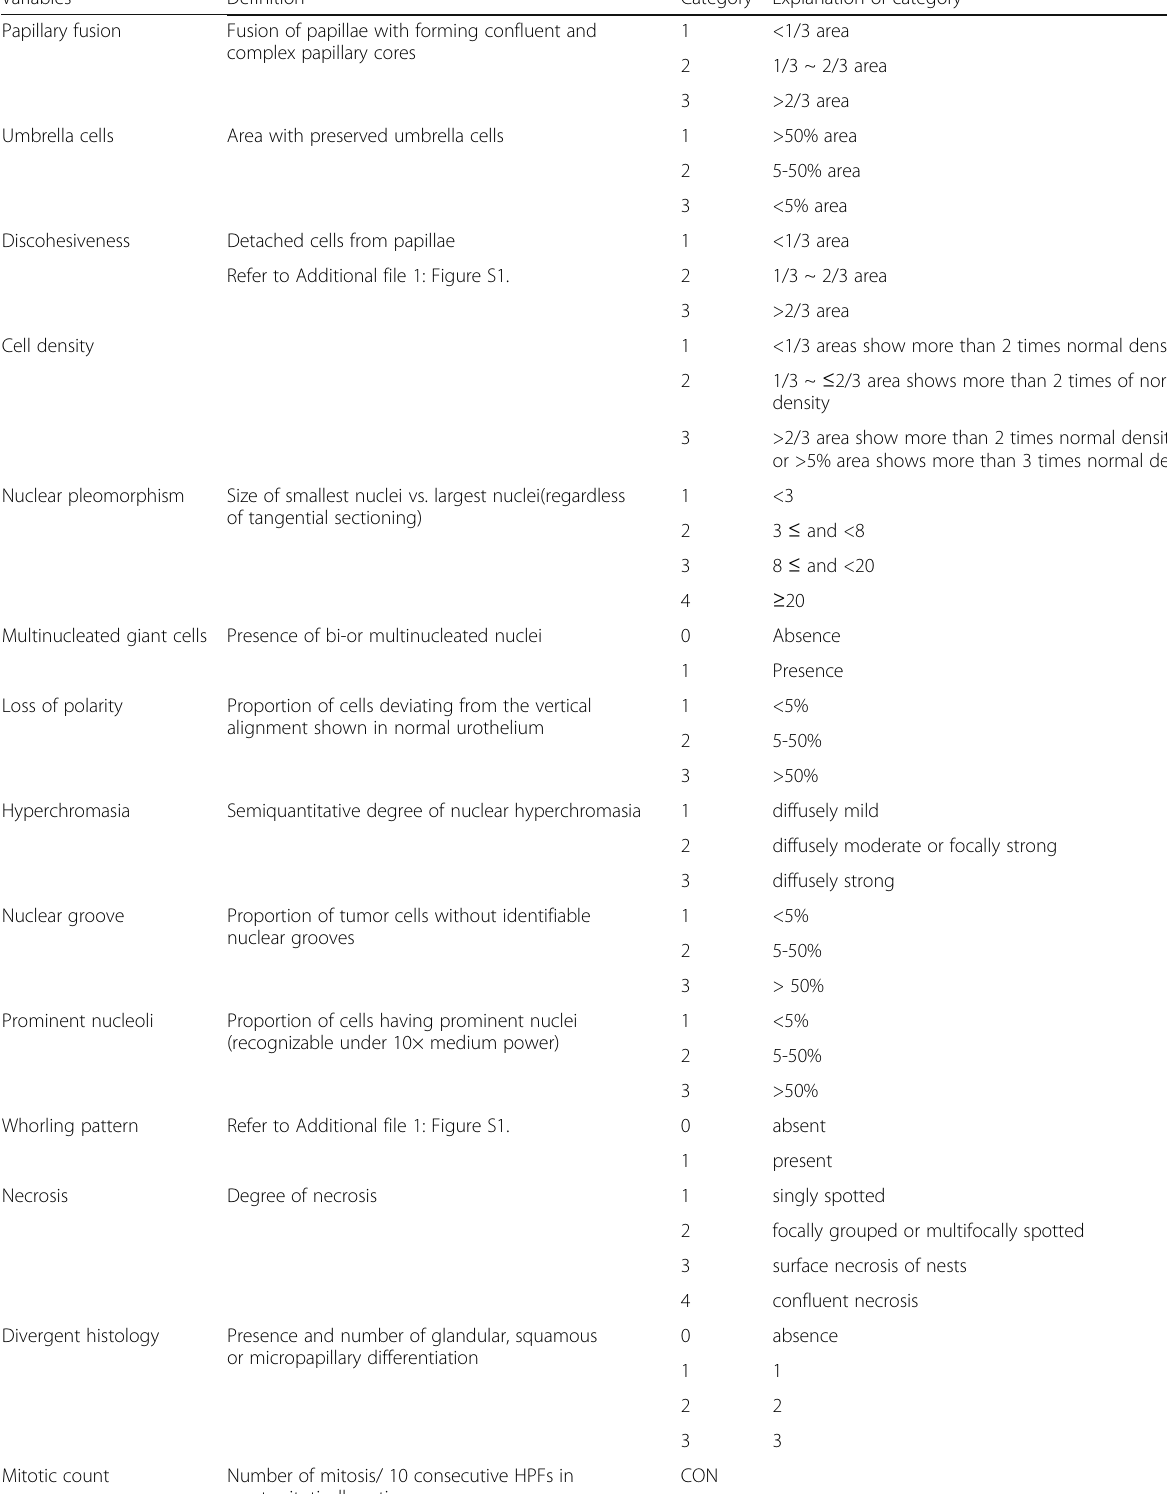
Table 2 Histologic parameters evaluated in this